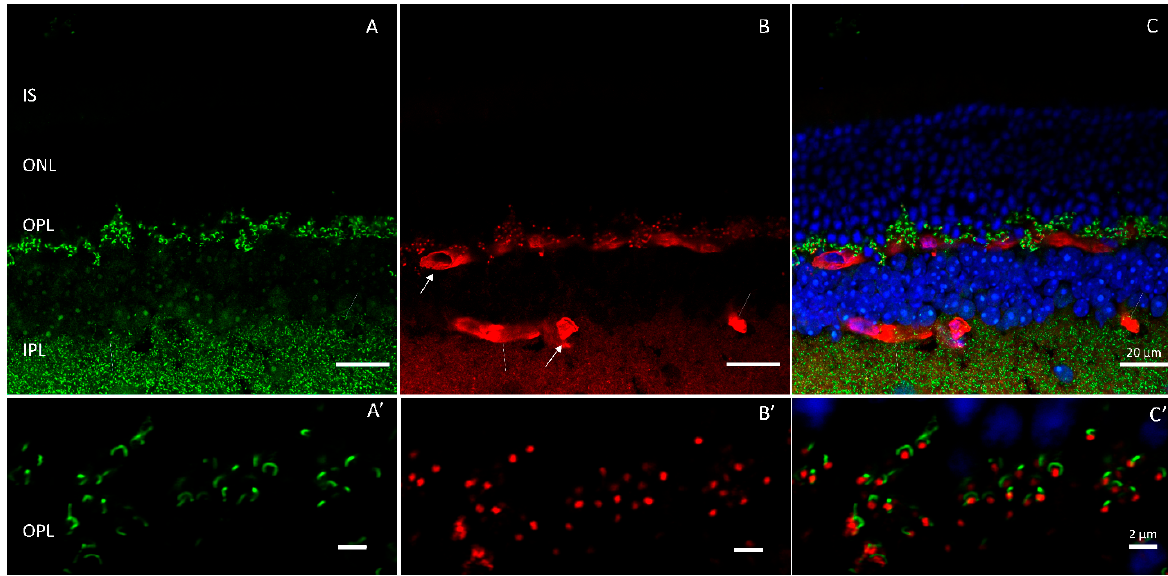
Figure 7. Dystroglycan is localized to the outer plexiform layer of the retina. Shown is antibody staining of an adult wildtype mouse retina labeled with ( A ) Ribeye (green) and ( B ) dystroglycan (red). ( C ) merged. Outer plexiform layer shown in ( A’ – C’ ). Retinal vasculature ( arrows ). Scale bar = 20 µ m in ( A – C ) and 2 µ m in ( A ’– C